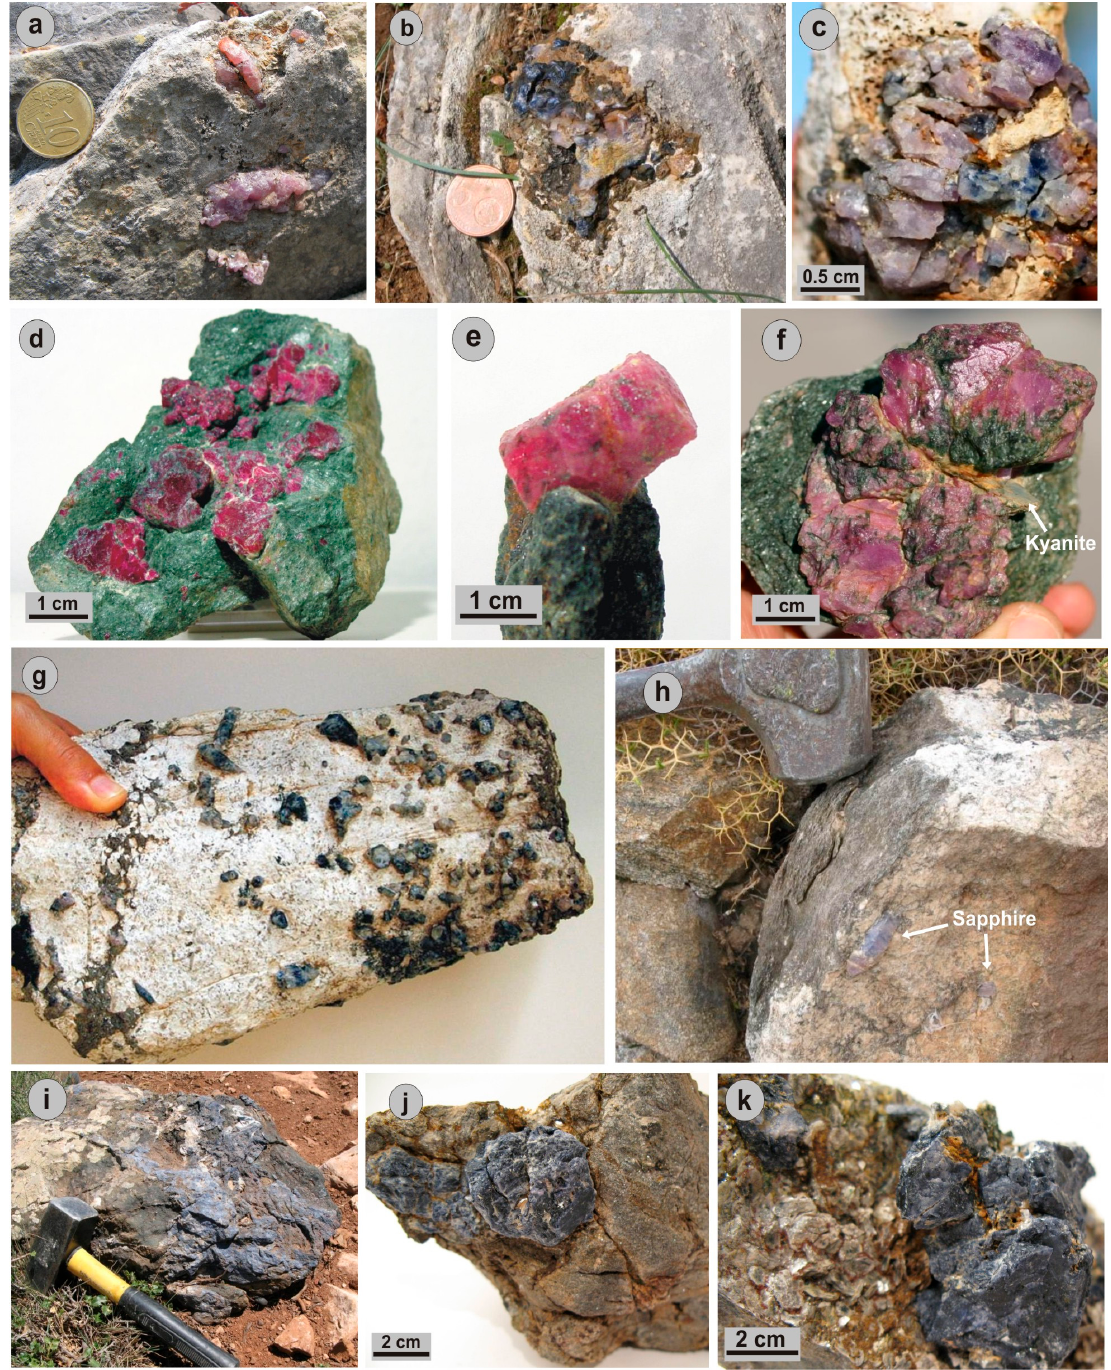
Figure 3. Field photographs and handspecimens demonstrating gem corundum crystals of Greece: ( a – c ) Pink, blue, to purple sapphires within Xanthi marbles; ( d , e ) Deep red-colored ruby with both tabular and barrel-shaped crystals within pargasite schist from Paranesti/Drama; ( f ) Ruby associated (replacing) kyanite, Paranesti/Drama; ( g ) Barrel-shaped blue and colorless sapphires hosted within anorthite-rich desilicated pegmatite (plumasite) and associated with phlogopite and tourmaline (schorlite) from the first Kinidaros locality, Naxos island; ( h ) Purple to pink sapphire within plumasite the later rimmed by phlogopite at the left part, second Kinidaros locality, Naxos island; ( i ) Blue sapphire in fissures within metabauxite at Kavalaris Hill, southern Naxos island; ( j , k ) Blue sapphires and margarite as free growing crystals of probably hydrothermal origin within fissure of metabauxites, Ikaria island.